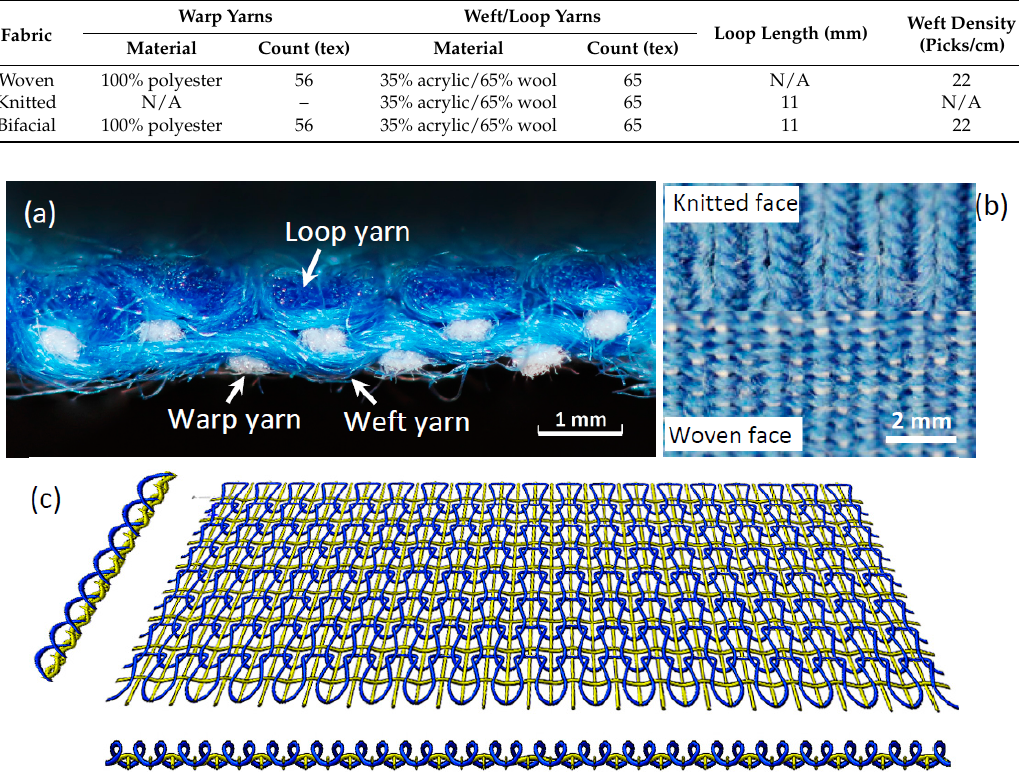
Figure 1. Bifacial fabric ( a ) the cross ‐ section in the warp direction; ( b ) knitted (top) and woven (bottom) face; ( c ) schematic structure.